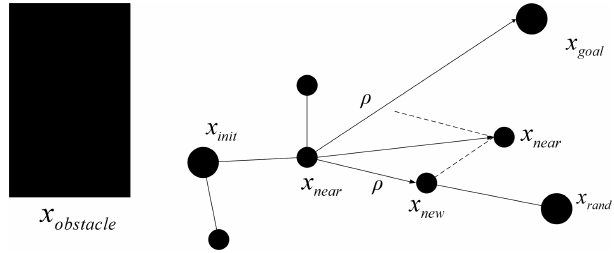
Figure 6. Extension map of RRT algorithm with added repulsion component.